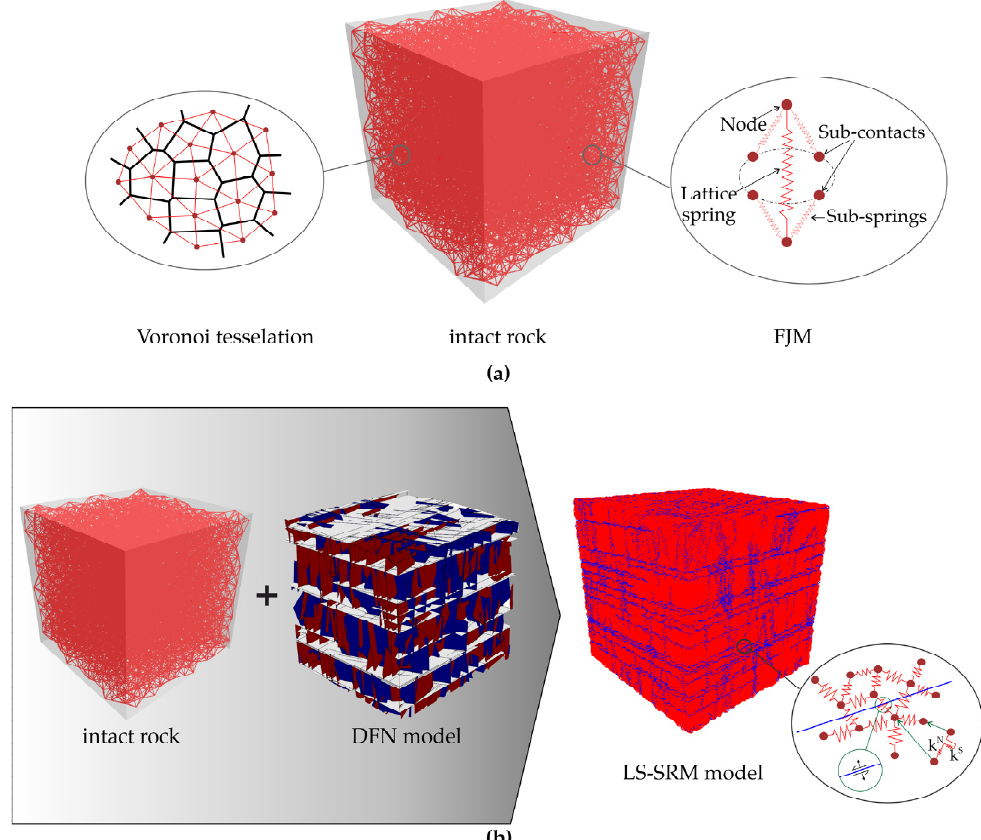
Figure 1. General buildup using the LS ‐ SRM modeling approach. ( a ) Rock mass model utilizing the lattice ‐ spring ‐ based approach using Voronoi tessellation in combination with the flat joint model (FJM); ( b ) LS ‐ SRM model showing the coupling of the lattice ‐ spring ‐ based model with the DFN model. Joint springs created by the DFN model are shown in blue.